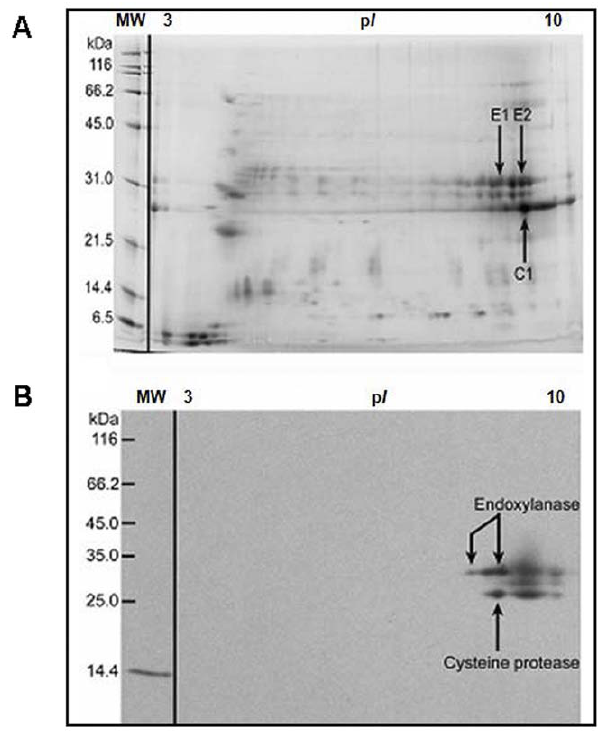
Figure 3. 2D-SDS-PAGE of BGP coat proteins (cyclohexane- soluble) stained with Sypro Ruby and IgE-immunoblotting. Pollen coat proteins were separated first by isoelectric point and then by molecular weight. Labeled spots were excised, destained, and digested with trypsin for peptide mass fingerprinting. ( A ) The identities of spots E1, E2, and C1 were verified by mass-spectrum peptide identification as two endoxylanases and a cysteine protease. Two- dimensional IgE-immunoblotting of BGP coat proteins ( B ). Approxi- mately 50 m g of pollen coat proteins were loaded into an IPG strip (pH 3–10). Following 2D-SDS-PAGE, Western blotting was performed, and the membranes were probed with human pooled allergic sera and detected with anti-human IgE antibodies as shown in Figure 2. The IgE- reactive spots corresponded to E1, E2, and C1 spots on 2D-SDS-PAGE in Figure A. IgE in the pooled sera also reacted with the 14.4 kDa mass marker, lysozyme from chicken egg white. 2D-SDS-PAGE and 2D- Western blot were repeated three times and generally found to